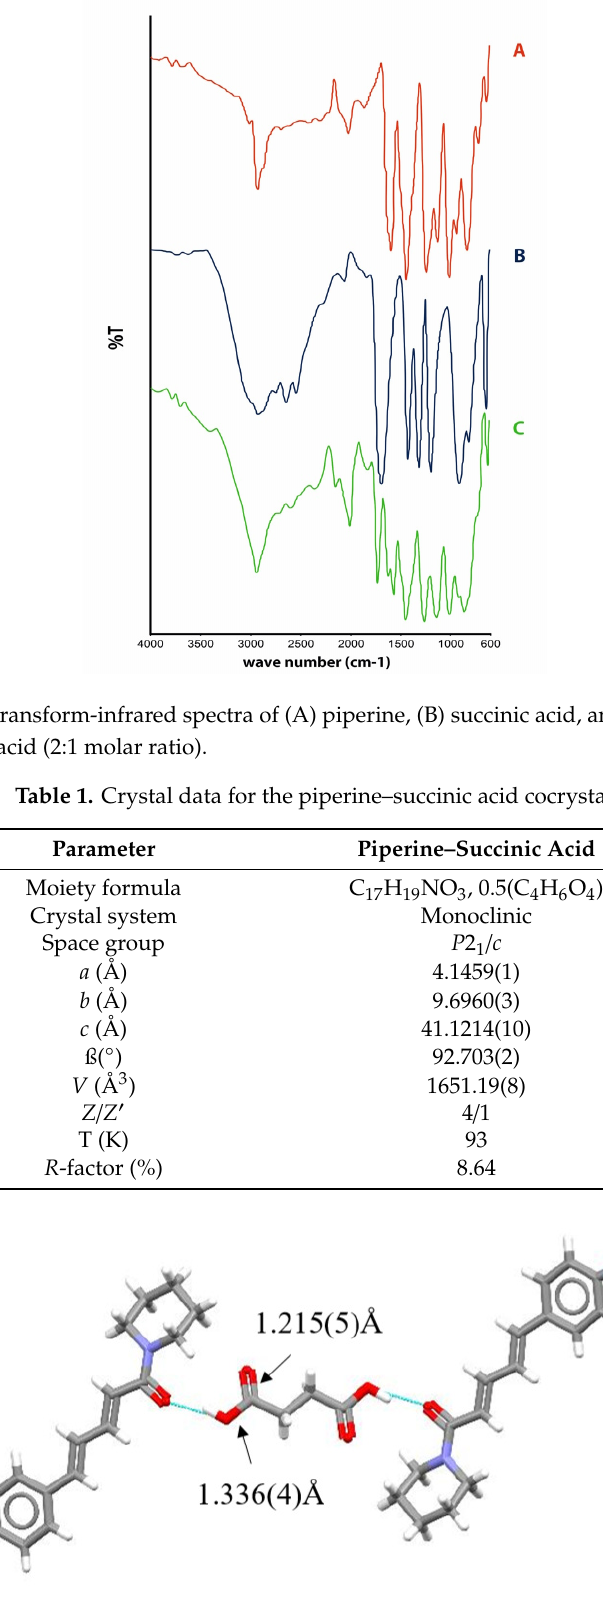
Figure 4. H-bond between piperine and succinic acid and the three-molecule unit of piperine and succinic acid.